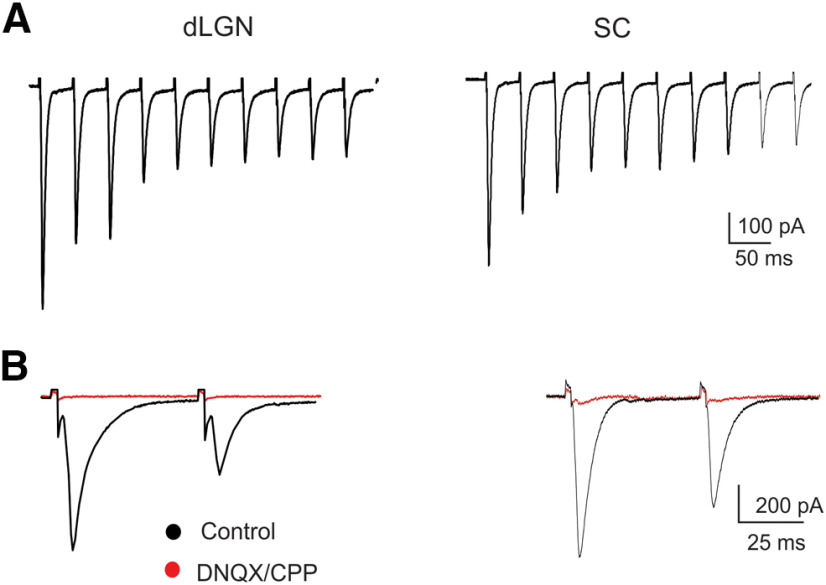
Excitatory glutamatergic synaptic transmission in dLGN and SC. A, Whole-cell voltage-clamp recordings showing the excitatory postsynaptic activity evoked by repetitive electrical stimulation of the OT for dLGN (left) and SC (right) neuron. Repetitive stimulation at 20 Hz evoked a train of EPSCs that rapidly depressed with each successive pulse. B, Paired stimulation (ISI, 50 ms) also led to strong paired-pulse depression in which the amplitude of the second (EPSC2) is greatly reduced compared with the initial one (EPSC1). Responses were abolished (red traces) by the bath application of glutamate receptor antagonists (AMPA: DNQX 25 μm) and (NMDA: d-CPP 20 μm). All responses recorded at −70 mv.